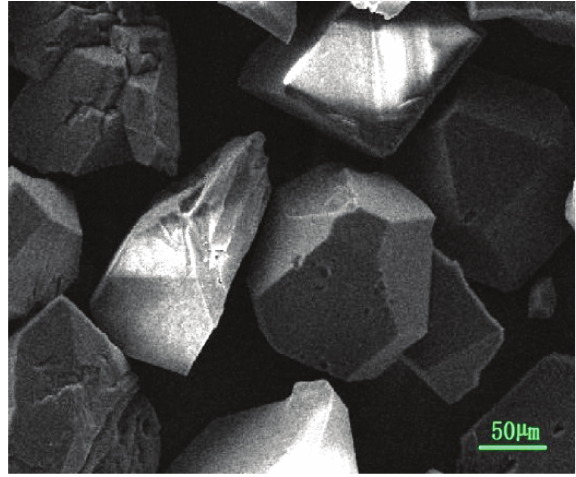
Figure 1: SEM micrographs of uncoated diamond.